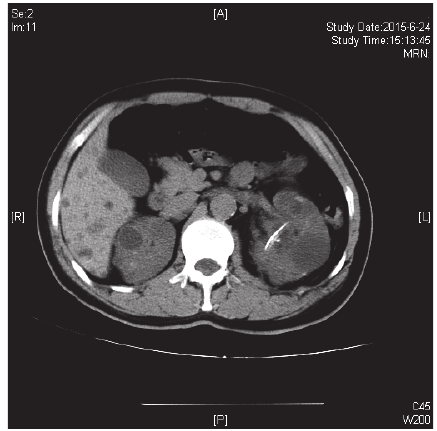
Figure 2: Nephrectomy tube after PCNL